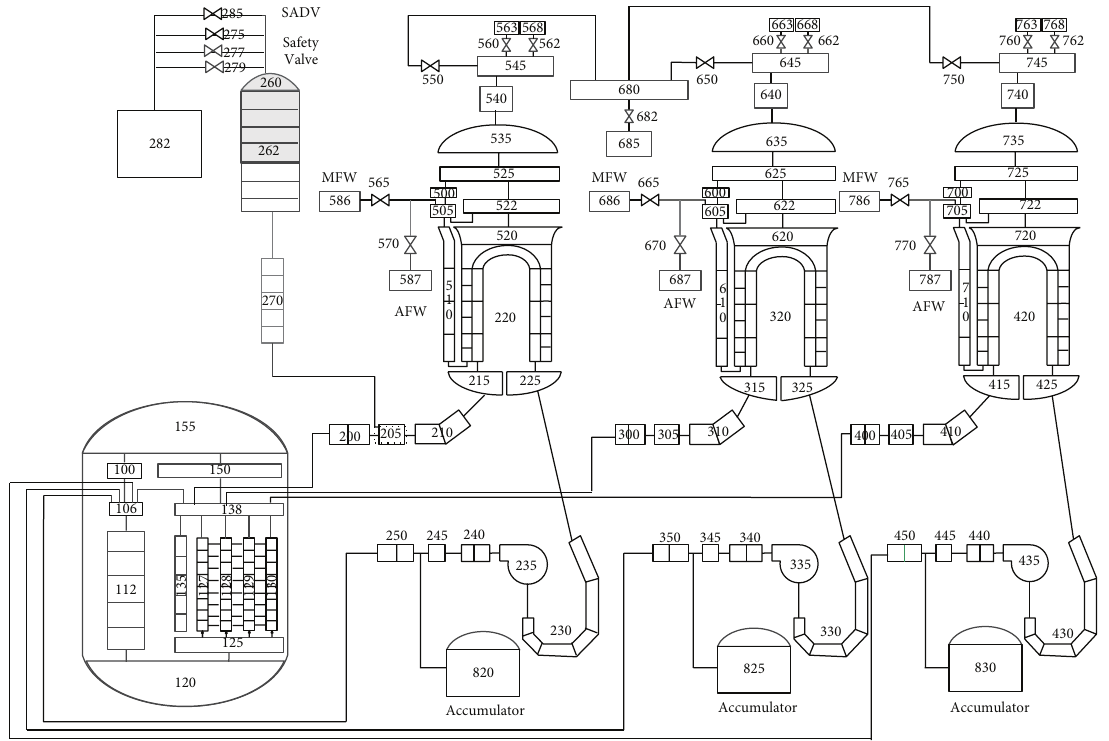
Figure 1: Node of plant